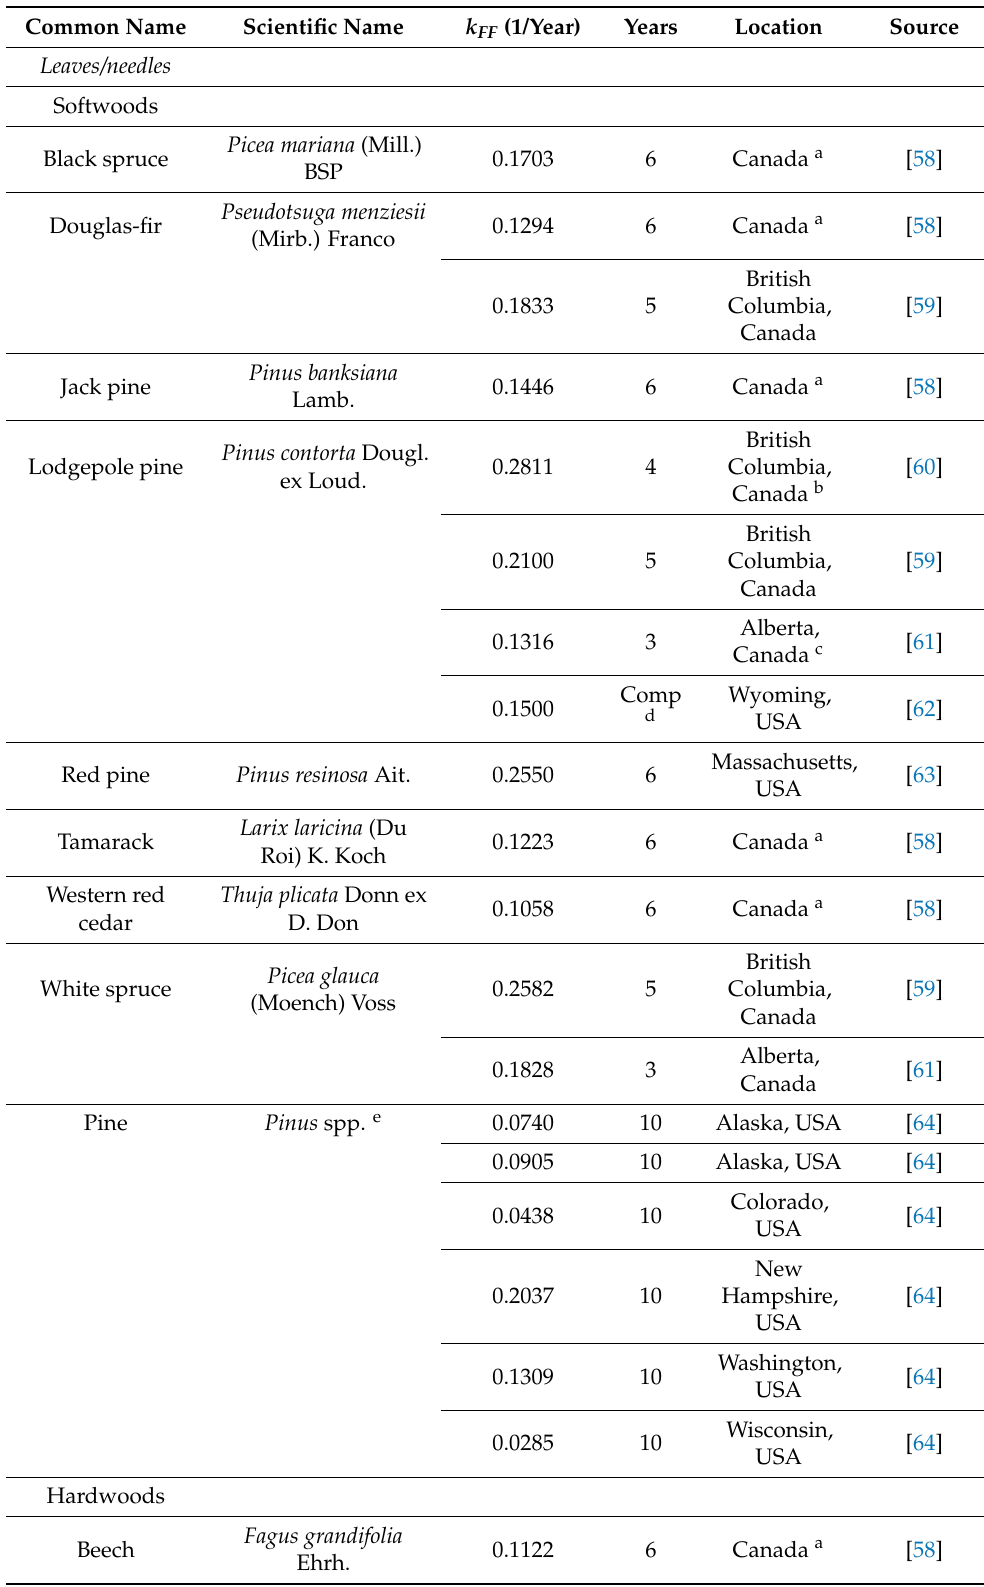
Table 3. Estimated decay rates of forest floor carbon ( k FF ) in North American boreal forests (where “Years” indicates study